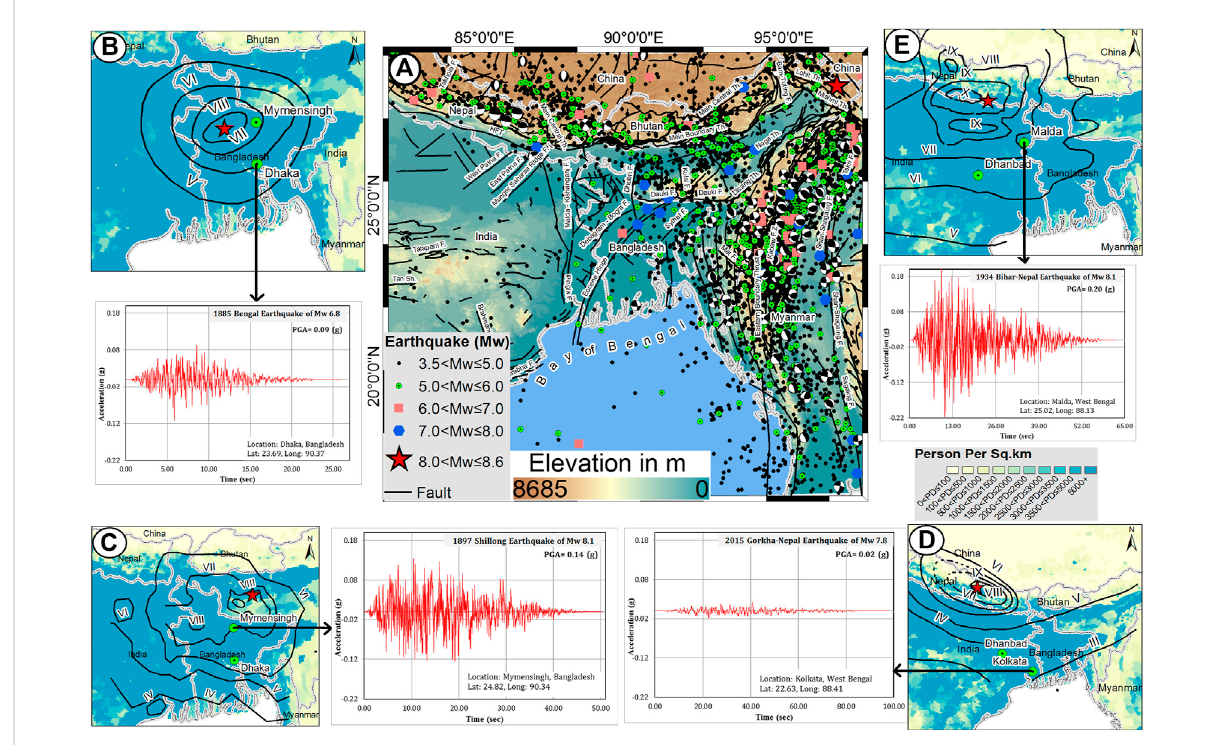
FIGURE 1 (A) Seismotectonic setting of Bengal Basin and its adjoining regions (modi fi ed after Dasgupta et al., 2000; Nath and Thingbaijam, 2012; Nath et al., 2017; Nath et al., 2021a). The isoseismal maps overlaid on the demography of the region are depicted in (B) for the 1885 Bengal earthquake of M W 6.8 along with its simulated accelerogram at Dhaka, (C) for the 1897 Shillong earthquake of M W 8.1 along with its simulated accelerogram at Mymensingh, (D) for the 2015 Gorkha – Nepal earthquake of M W 7.8 along with its simulated accelerogram at Kolkata, and (E) for the 1934 Bihar – Nepal earthquake of M W 8.1 along with its simulated accelerogram at